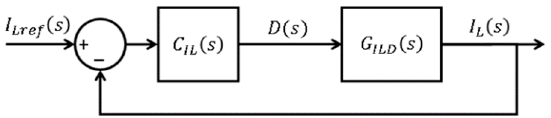
Figure 8. Block diagram of the voltage regulation loop operating in power transfer mode.